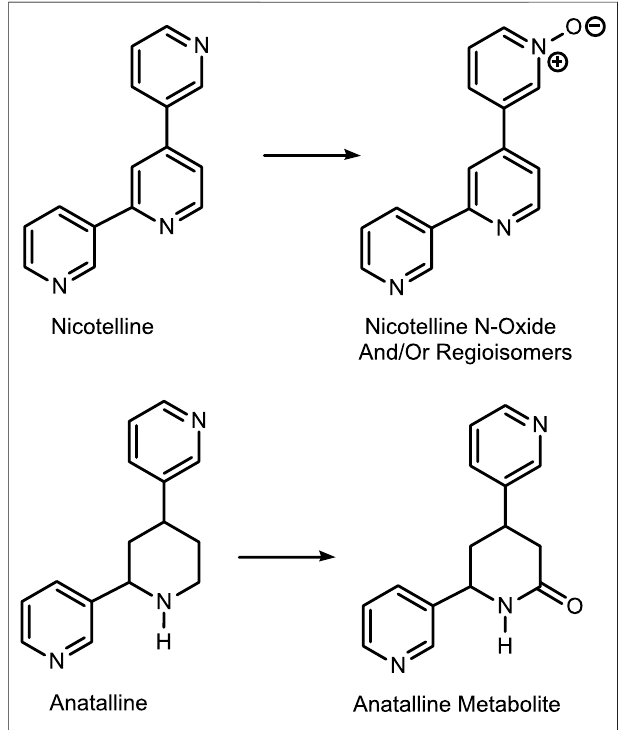
FIGURE 2 | Metabolism of nicotelline and